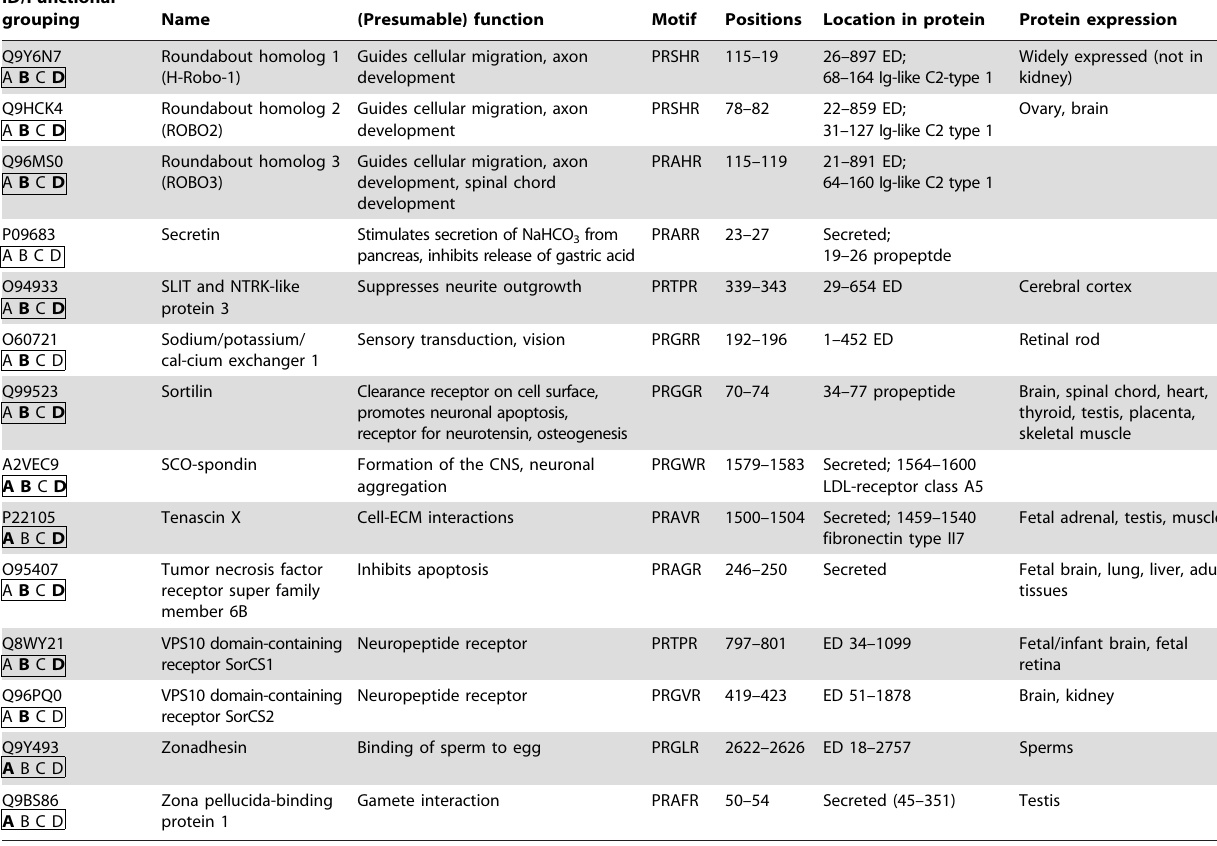
Table 6. Potential novel thrombin